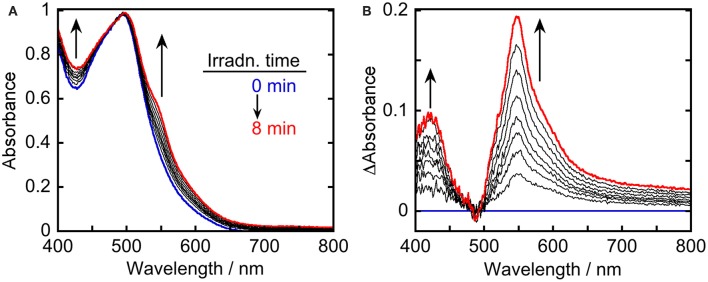
UV-vis (A) absorption and (B) differential absorption spectral change of a DMA-TEOA (5:1 v/v, 4 mL) solution containing Ru(pic) (0.1 mM) and BIH (0.2 M) during irradiation using light at λex = 480 nm (0–8 min at 1-min intervals). The incident light intensity was 5.0 × 10−9 einstein·s−1. Blue and red lines represent spectra at 0 and 8-min irradiation, respectively.